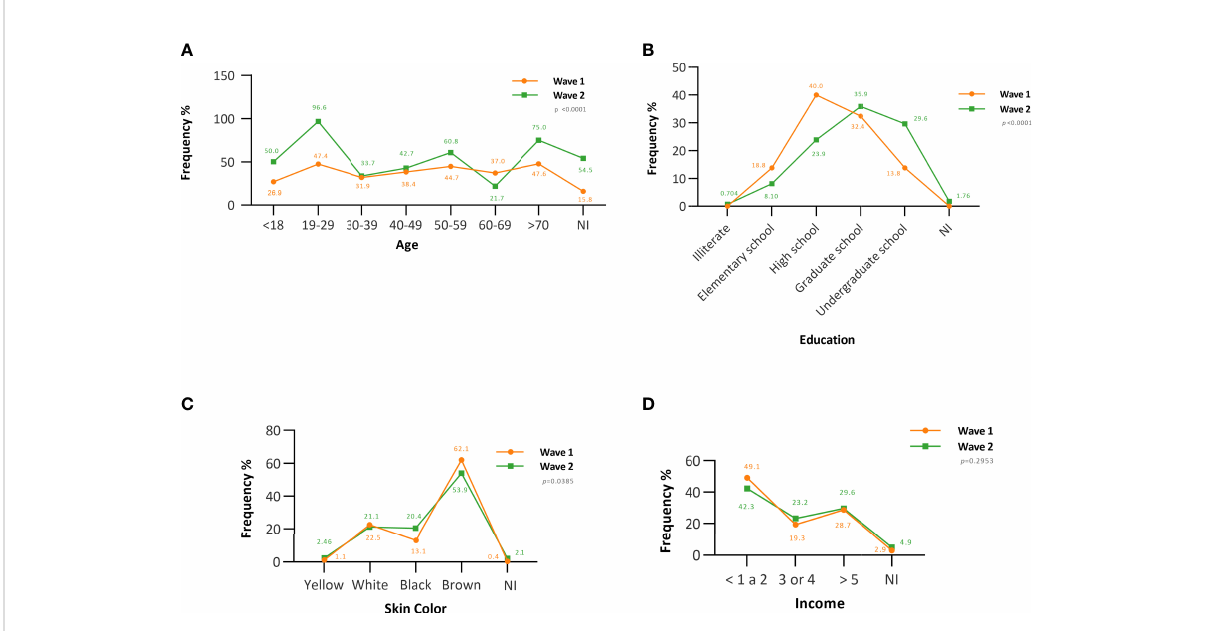
FIGURE 1 The frequency of anti-SARS-CoV-2 IgG antibodies according to socioeconomic characteristics. (A) Age-associated seroprevalence. (B) Seroprevalence associated with education level. (C) Seroprevalence associated with skin color. (D) Seroprevalence associated with family income. NI, not informed.